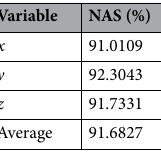
Table 6. The fitness of the UAV translational states in the experimental